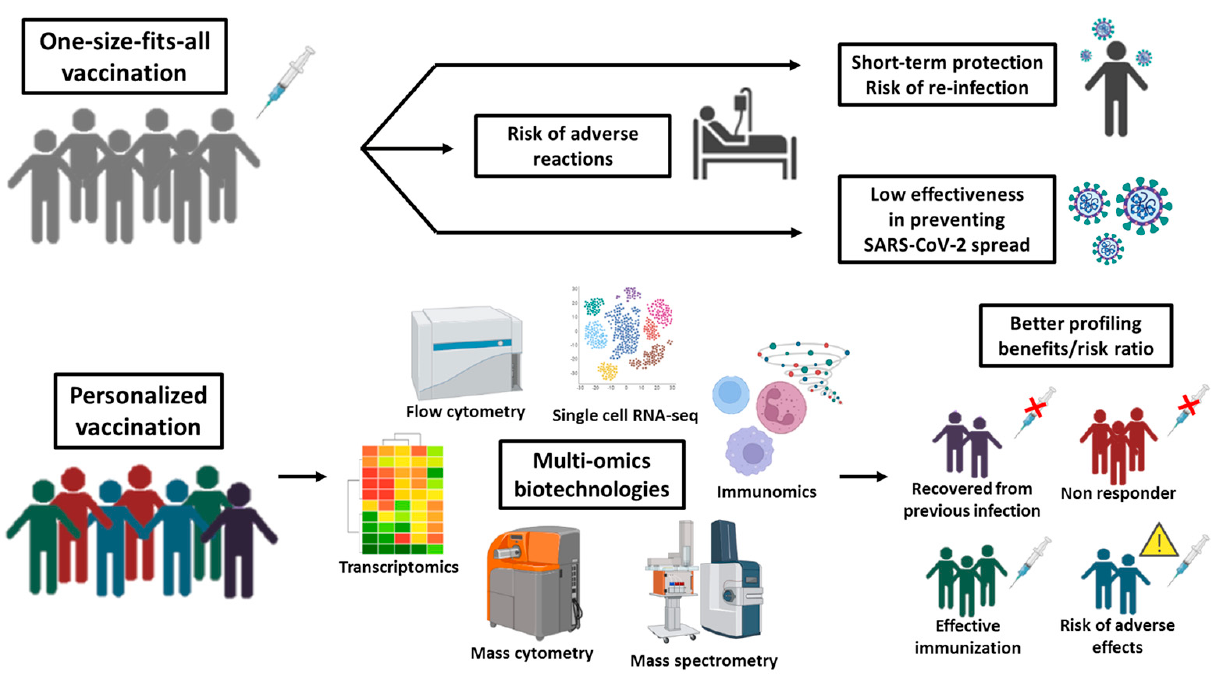
Figure 2. Mass versus personalized vaccination in the omics era. When the vaccine is administered to a large population without considering the individual pathophysiological condition(s), it is highly probable to observe inefficacy and/or immediate/late adverse effects in part of the vaccinated. Omics-biotechnologies allow a better subject profiling by investigating all the variables influencing the efficacy and safety of vaccines in view of personalized vaccination that targets the individuals who can benefit of it with negligible side effects while excluding those who may not respond (because immunocompromised) or are already immunized (by prior infection) or are predisposed to severe reactions ( e.g ., allergy).